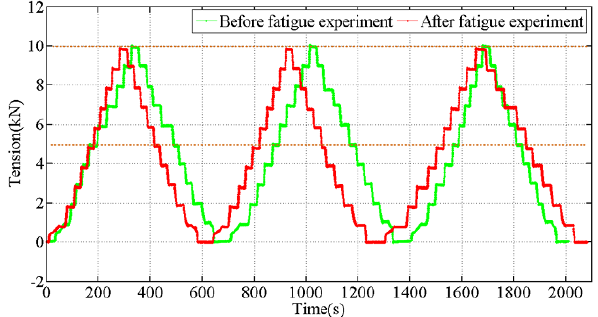
Figure 8 . The performance comparison of tension sensor before and after fatigue experiment. Figure 8. The performance comparison of tension sensor before and after fatigue